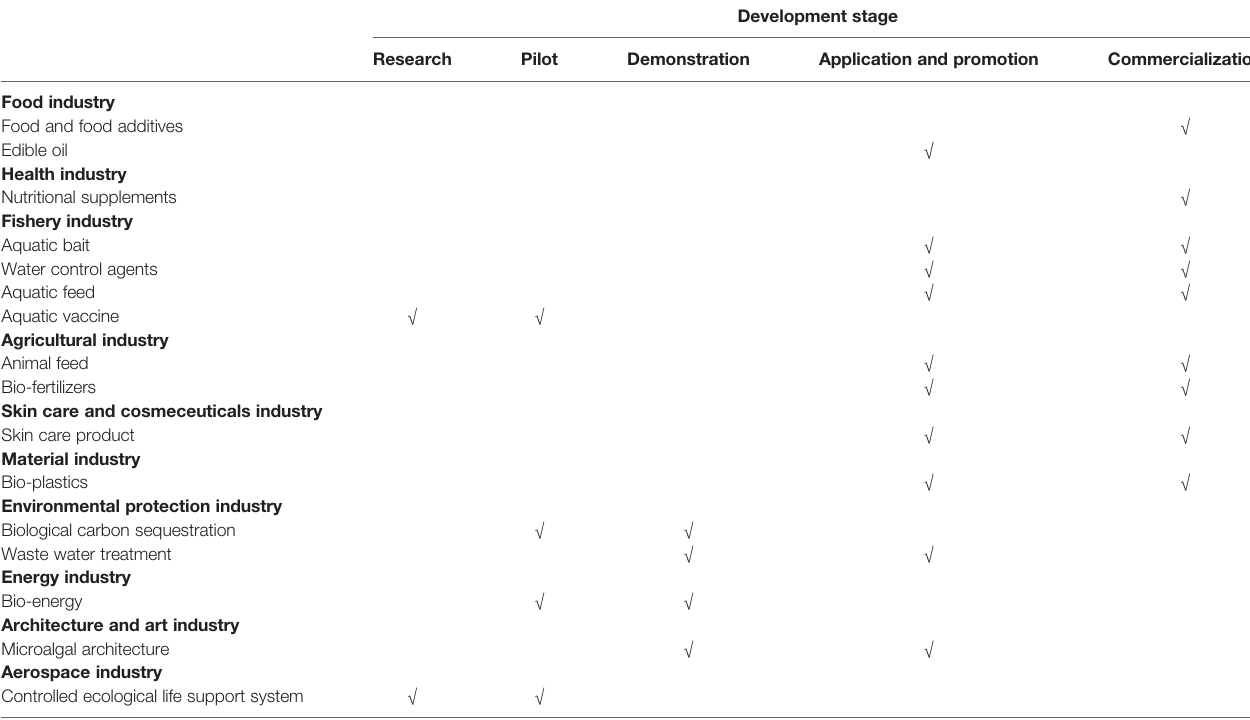
TABLE 3 | The stage of microalgae application in various